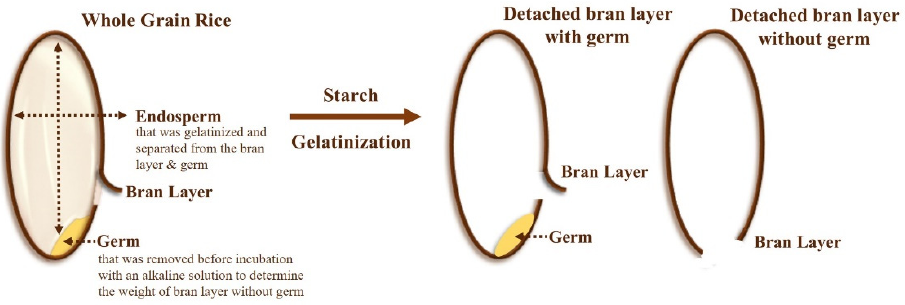
Figure 1. Separation of bran layer with germ or without germ from whole grain rice by the alkaline